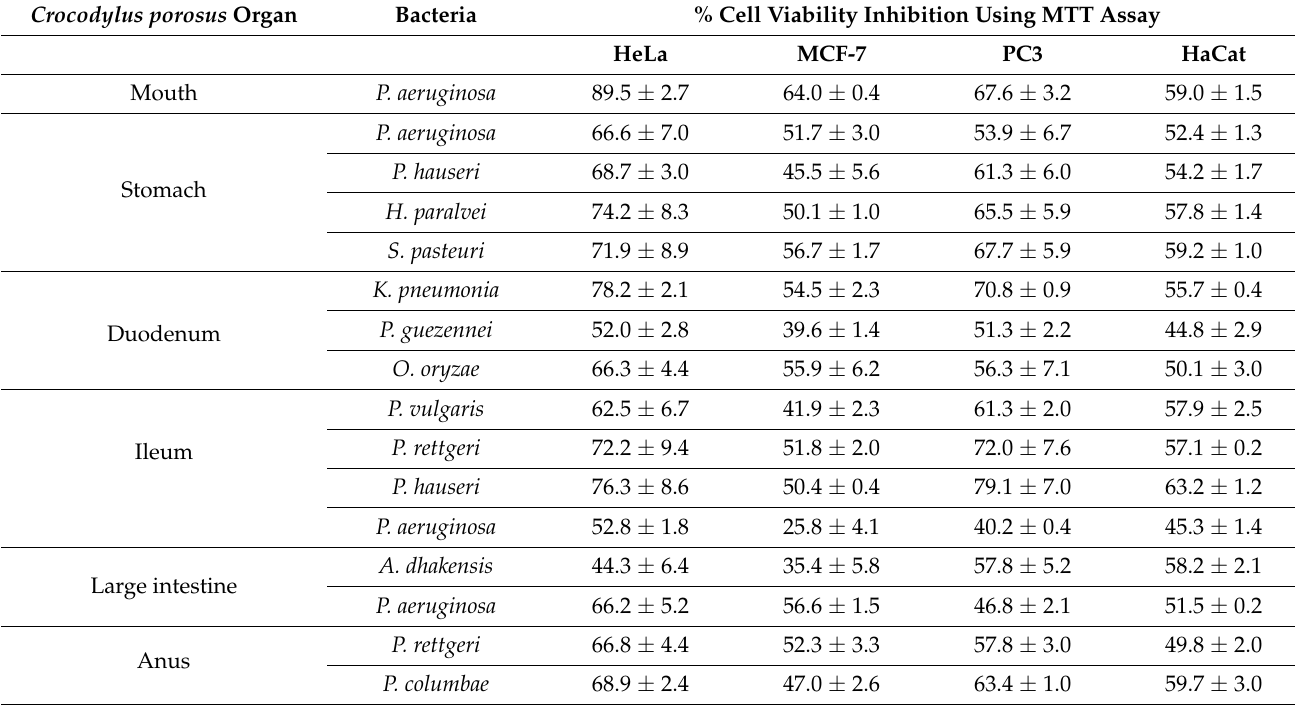
Table 2. MTT assay revealed that CM from selected gut bacteria of C. porosus affected cell viability. Crocodylus porosus Organ Bacteria